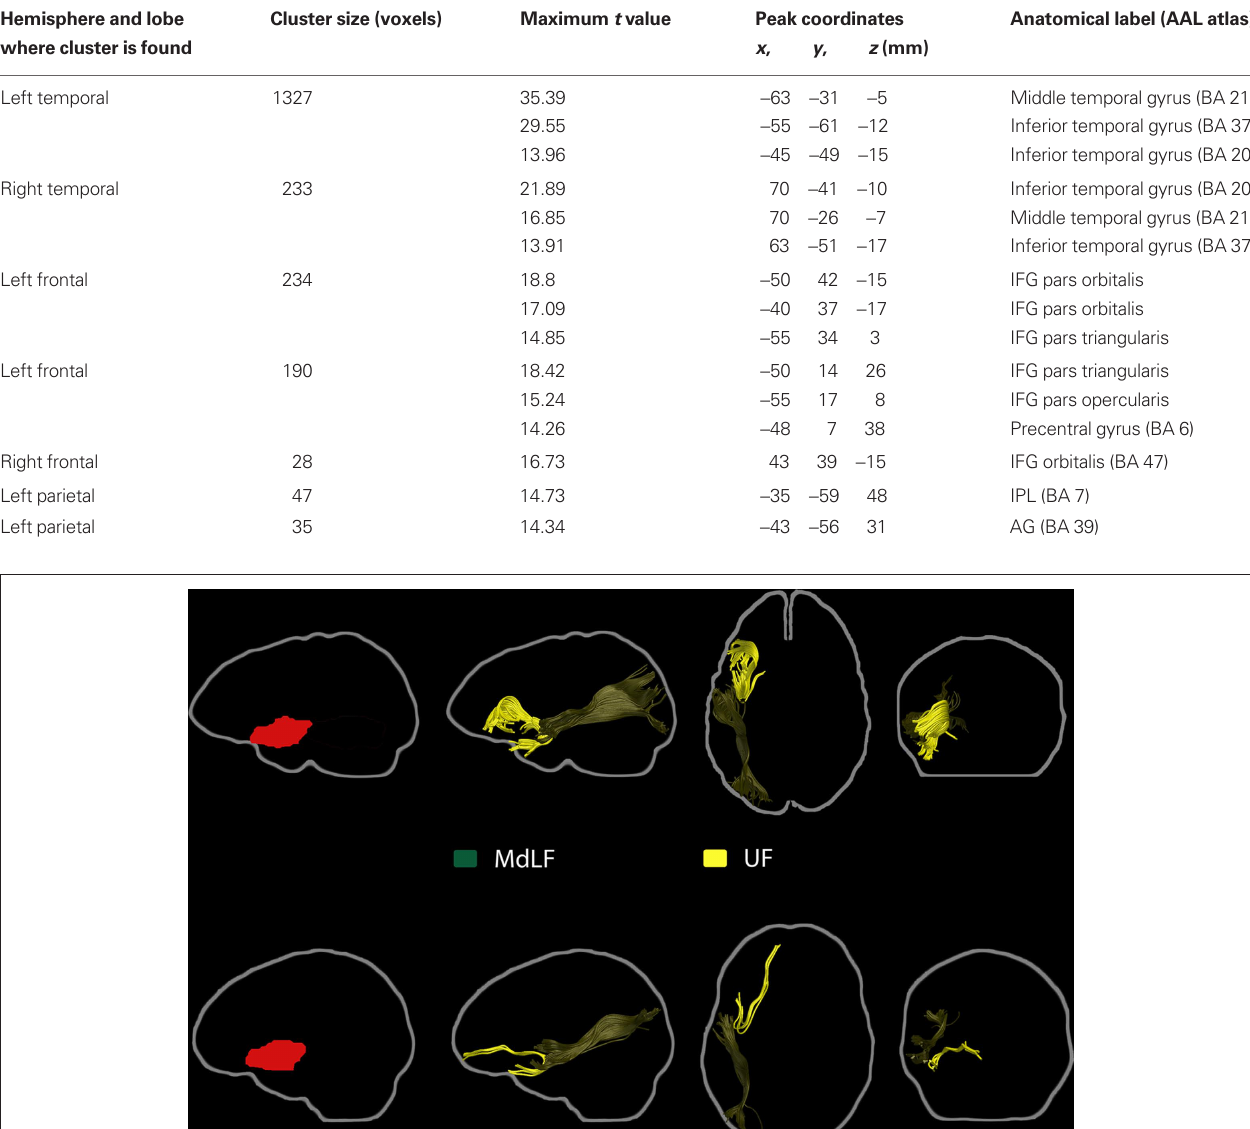
Table 1 | Cortical areas found to be functionally connected to the left MTg seed region at a stringent threshold for significance ( t > 12.13, cluster extent > 62.5 mm 3 ).